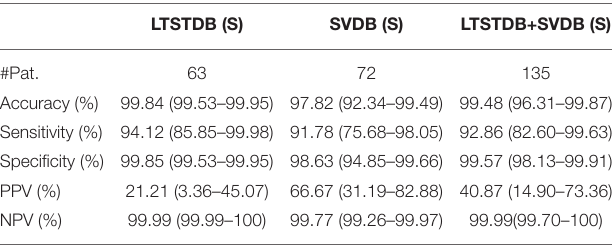
TABLE 4 | Patient-based classifier performance, median (IQR range) for the binary classification ( S – Other ).